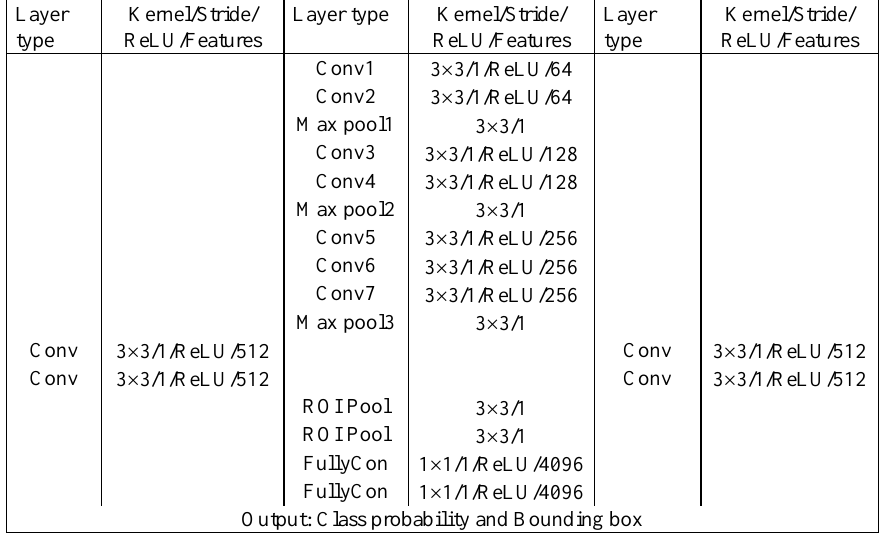
Table 3. Architecture of SAF